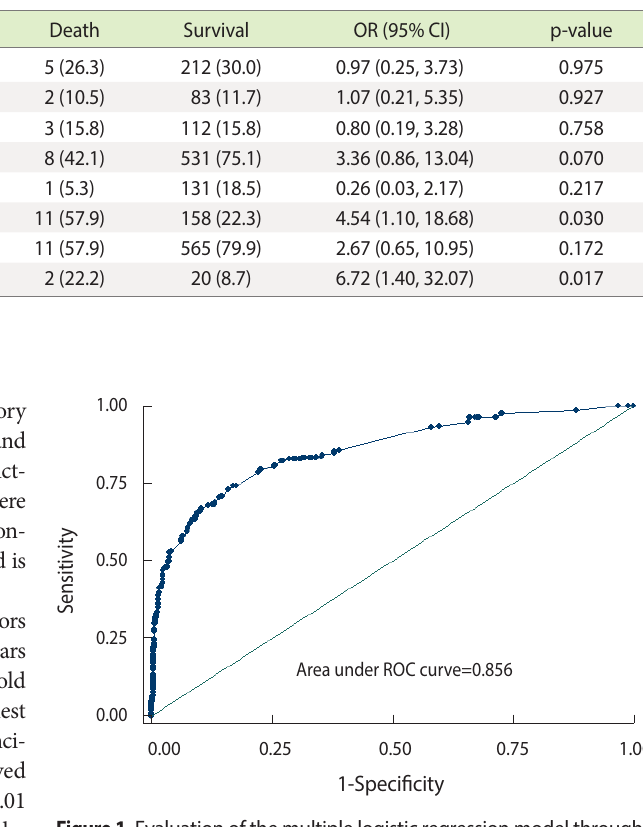
Table 4. Risk factors for mortality due to childhood poisoning by multiple logistic regression